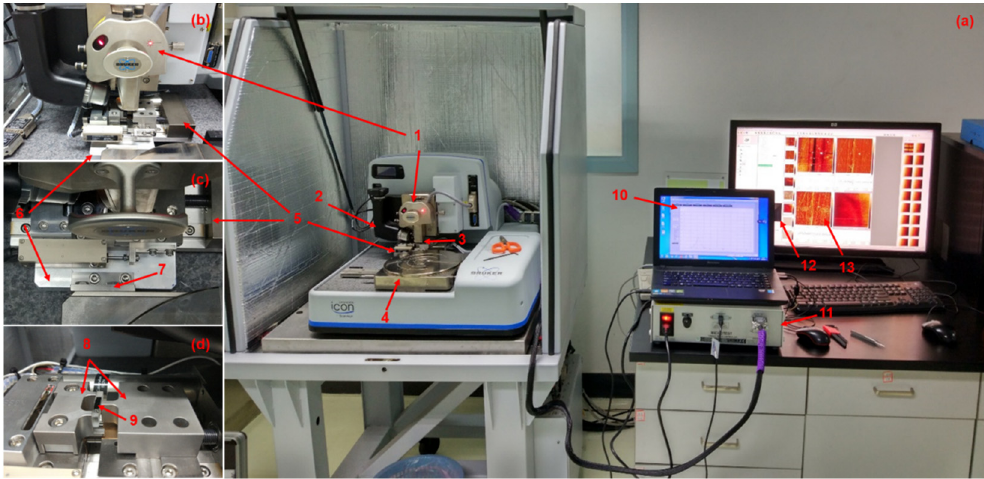
Figure 1. ( a ) Microdynamic loading test system ( b ) Enlarged view of AFM scanner and micrody-